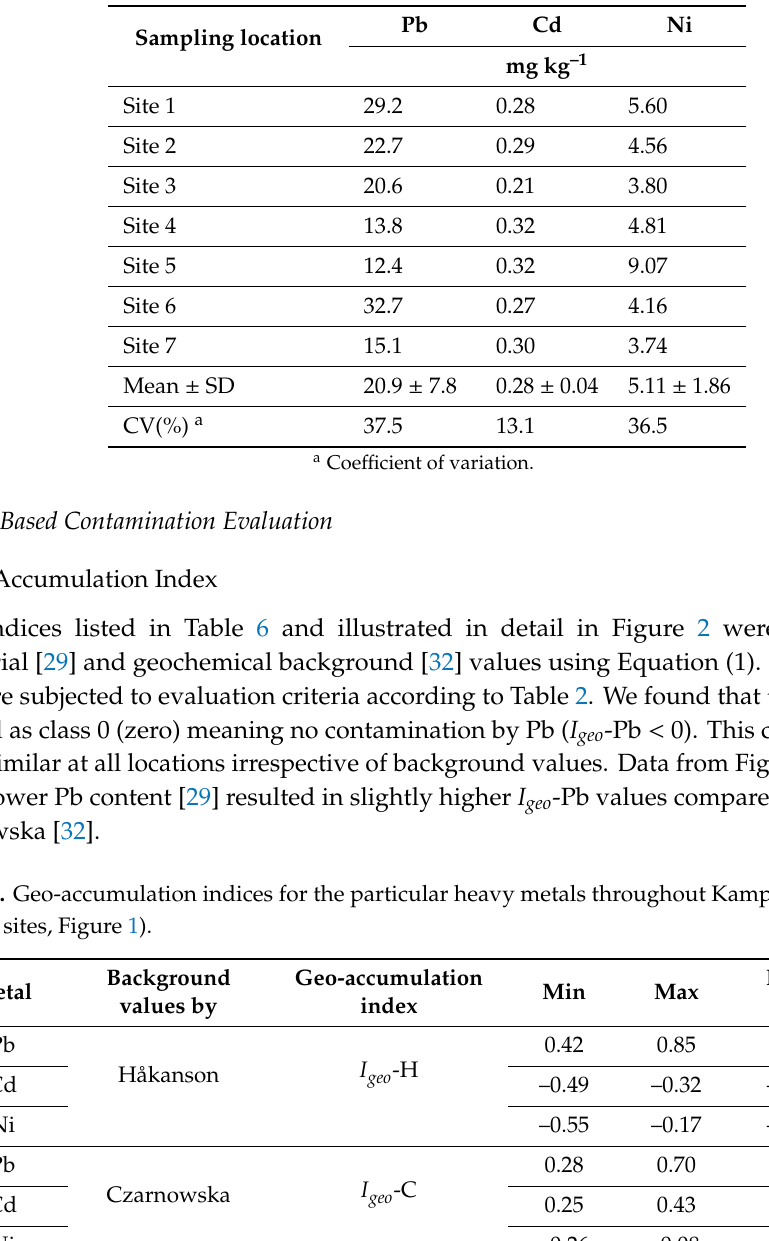
Table 5. Pseudo-total heavy metal contents at the Kampinoski National Park for the whole 5–50 cm depth sampling layer.